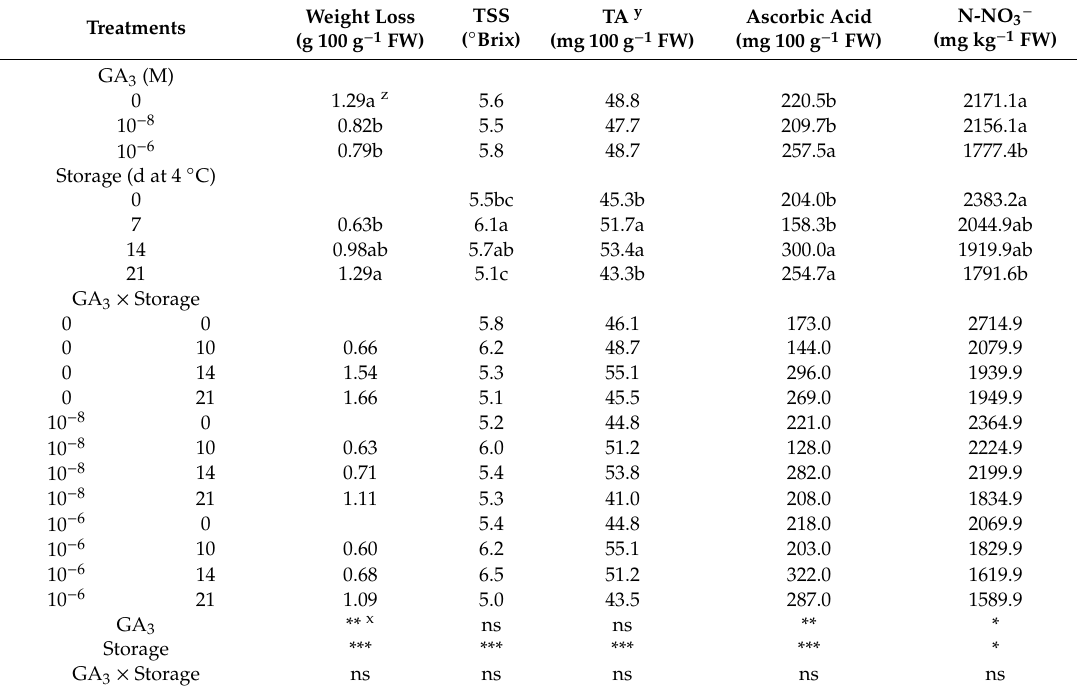
Table 4. E ff ect of GA 3 and storage duration (d) on weight loss, total soluble solids (TSS), titratable acidity (TA), ascorbic acid, and nitrates of minimally processed